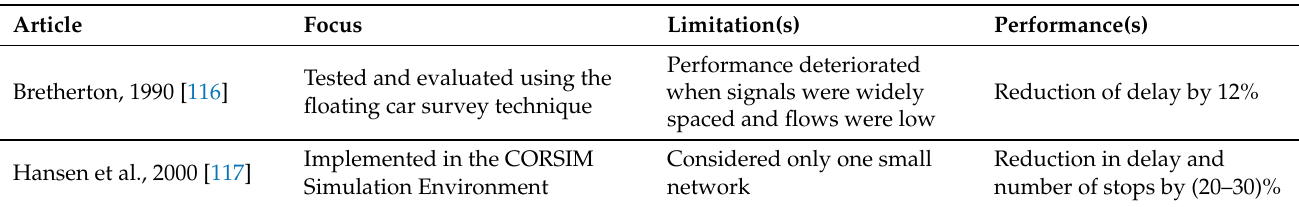
Table 19. Works found on the SCOOT.